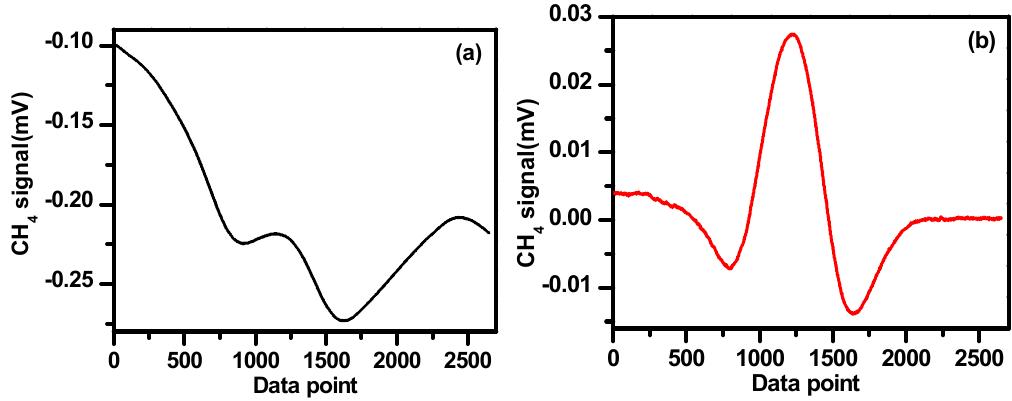
Figure 11. ( a ) 2f signal of 0.6 ppmv CH 4 associated with baseline and ( b ) 2f signal of 0.6 ppmv CH 4 after subtracting the baseline.